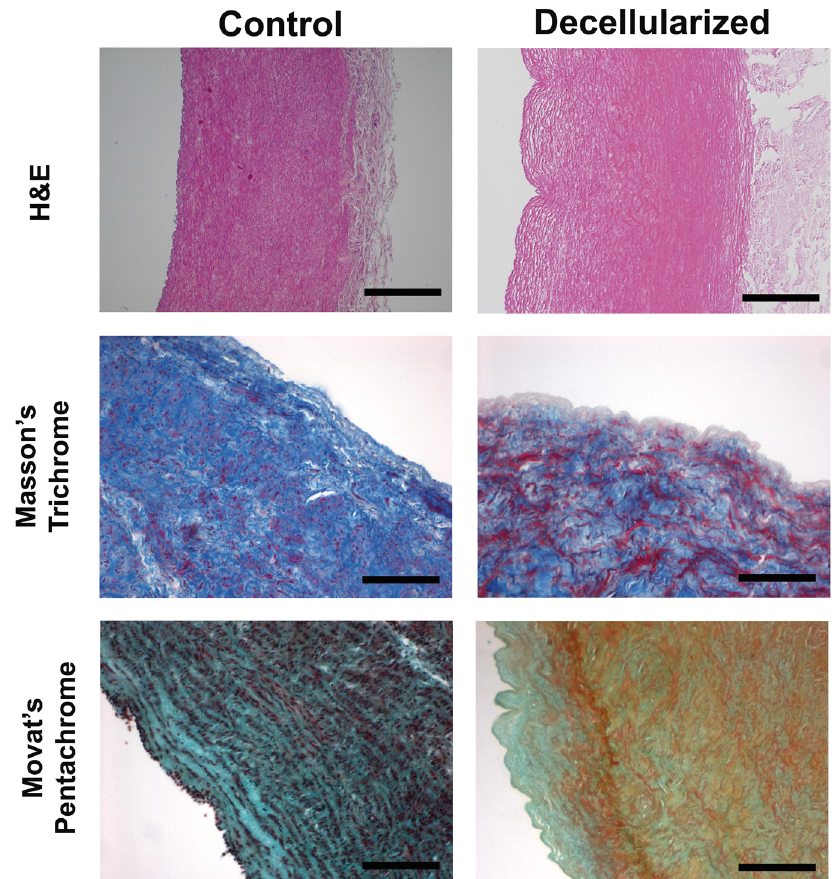
Figure 1. ECM composition of aortic arch samples. HE stain, Masson’s Trichrome stain and Movat’s Pentachrome stain show complete preservation of the ECM after the decellularization procedure of aortic arch specimens. Bars, 50 m m. Masson’s Trichrome stain: cytoplasm (red), collagen (blue), nuclei (dark brown). Movat’s Pentachrome stain: nuclei (dark purple to black), elastic fibres (purple to black), collagen (yellow), glycosaminoglycans (green), mucin (blue), cytoplasm (pink to brownish-red).